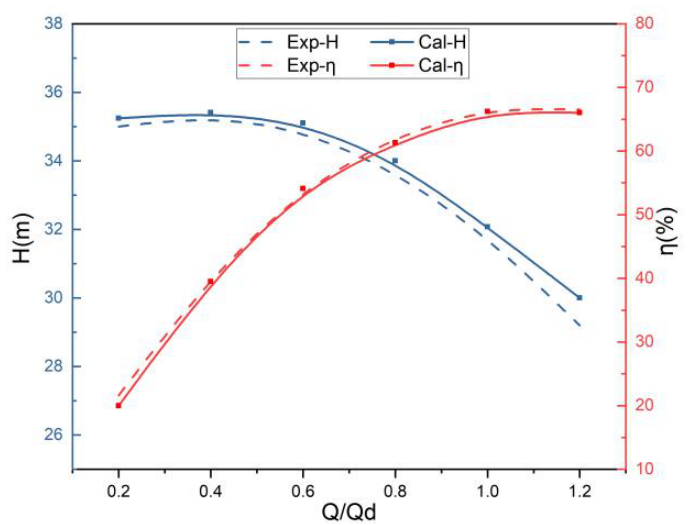
Figure 5. Simulation results of the centrifugal pump external characteristics and a comparison with the experiments .